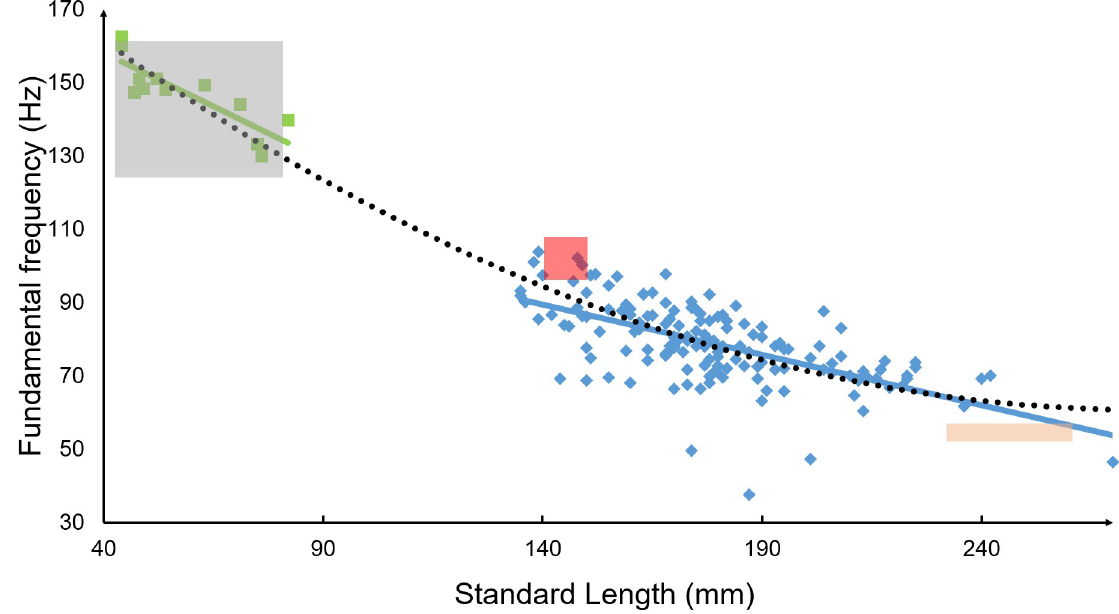
Fig 4. Fundamental frequency as a function of the standard length for red-bellied Pygocentrus nattereri . The three boxes show the data from [55]. Each box corresponds to the mean ± SD of a given size class. The green “ & ” are from [10] and the blue “” from this study. Linear regressions are presented for separated datasets and a polynomial model of all the